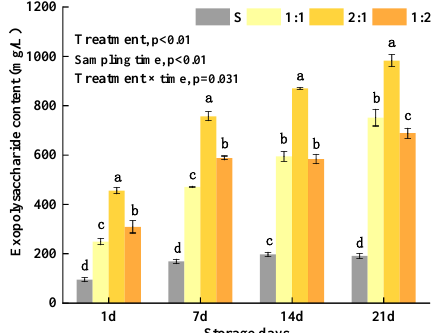
Figure 2. Content of EPS in yogurt with different proportions of MC5 added during storage. The control group S only has added commercial starters, the 1:1, 2:1, and 1:2 groups denote that the proportion of adding MC5 and commercial starters is in a ratio of 1:1, 2:1, and 1:2, respectively. Error bars represent the standard errors (se) of the model-fitted mean value ( n = 3). “a, b, c, d” indicate significant differences within yogurt groups during storage at p < 0.05.